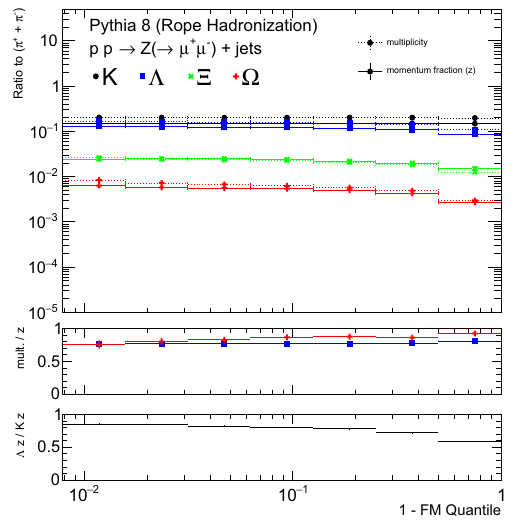
Fig. 4 Same as Fig. 3, but comparing the multiplicity inside jets with the average momentum fraction carried by those hadrons